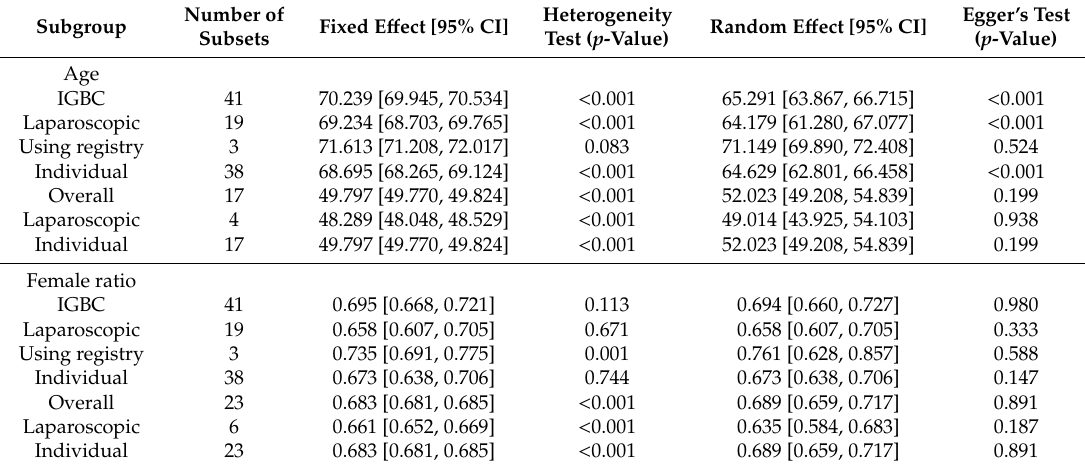
Table3. Comparisonsofageandfemaleratiobetweenincidentalandnon-incidentalgallbladdercancers.